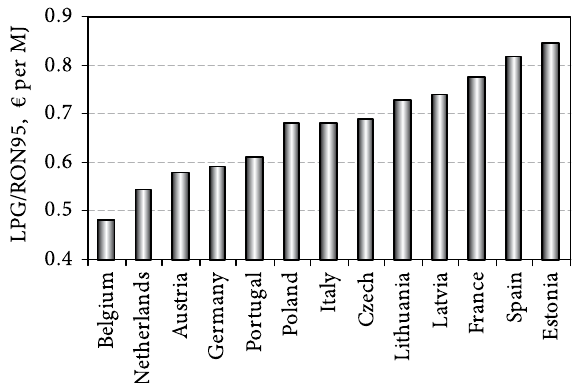
fig. 4. The ratio of LPG and gasoline prices in the EU countries, 2006